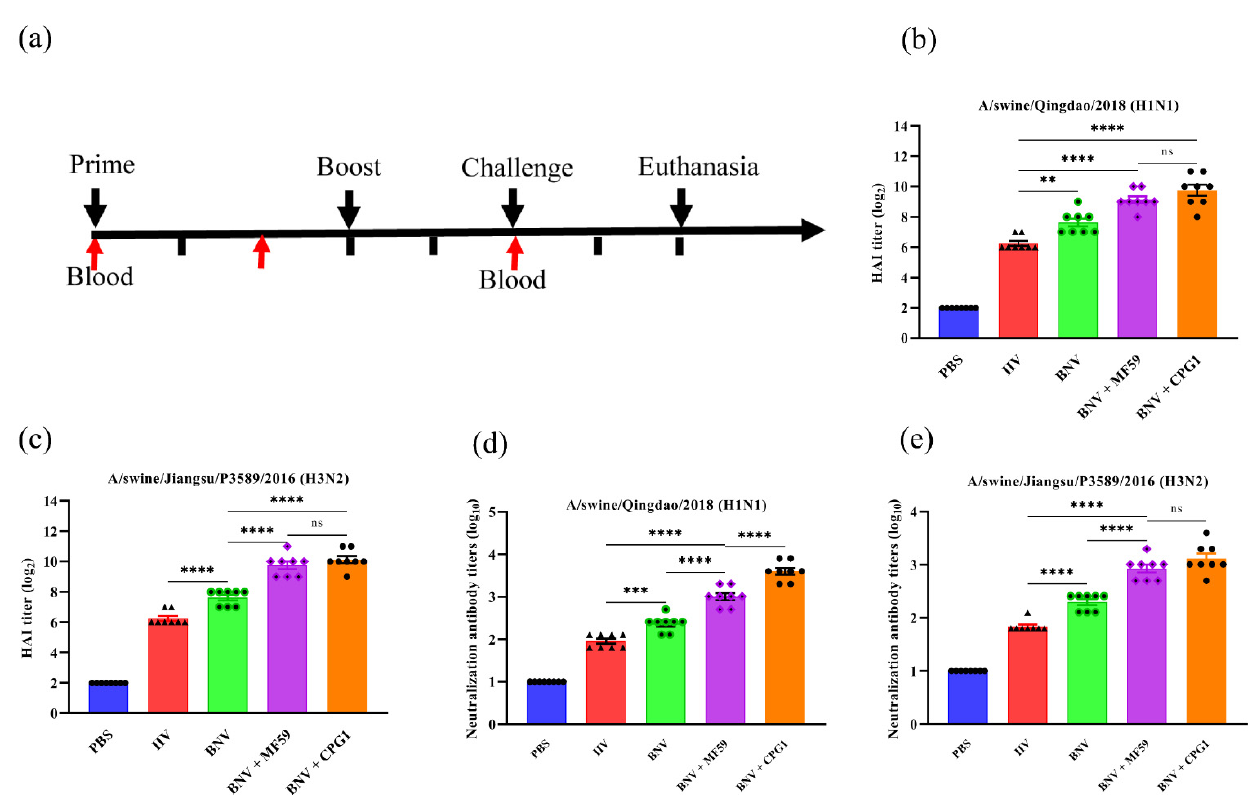
Figure 3. HAI and VN antibody responses in BNV immunized mice. ( a ) Schematic flow diagram of the animal immunization and challenge. ( b , c ) HAI antibody titers in mice after immunization with swine influenza bivalent nanoparticle vaccines ( n = 8). The results were calculated by the value of log2. Each symbol represents an individual mouse, and the horizontal bar indicates the geometric mean of the group. ( d , e ) VN antibody titers in mice after immunization with swine influenza bivalent nanoparticle vaccines ( n = 8). The results were calculated by the value of log10. Each symbol represents an individual mouse, and the horizontal bar indicates the geometric mean of the group. Values are presented as mean ± standard deviation (S.D). Statistical significance analysis was performed using one-way ANOVA and then multiple comparison tests (** p < 0.01; *** p < 0.001; **** p < 0.0001; ns, p > 0.05), and n.s. indicates no significance between the two compared groups ( n = 8). Three parallel experiments in each group were conducted.